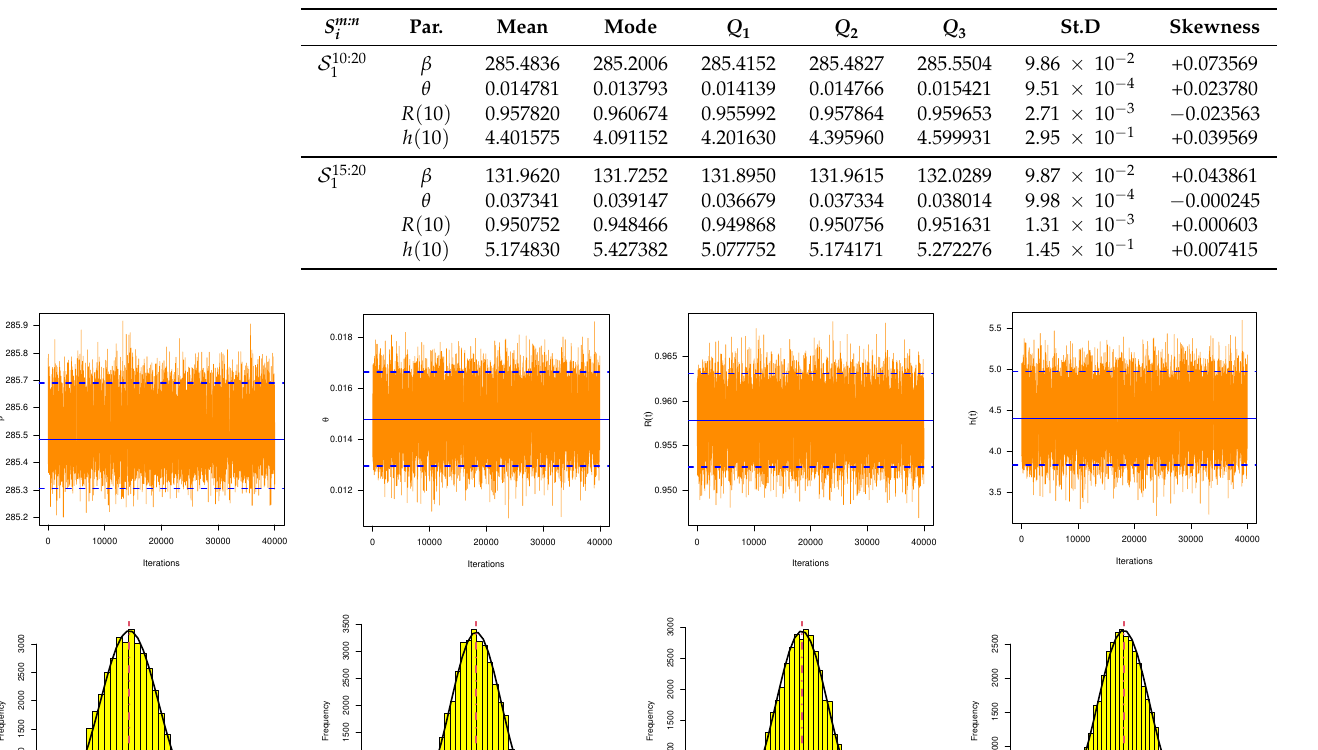
Table 8. Vital measures of MCMC outputs of β , θ , R ( t ) , and h ( t ) under SSB data.